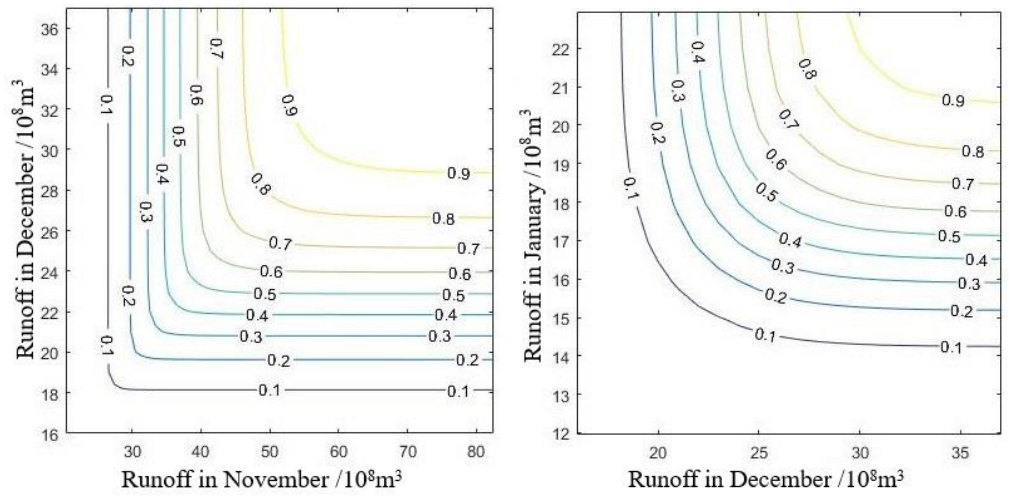
Figure 5. Joint probability distribution of incoming runoff in the NZD hydropower plant.